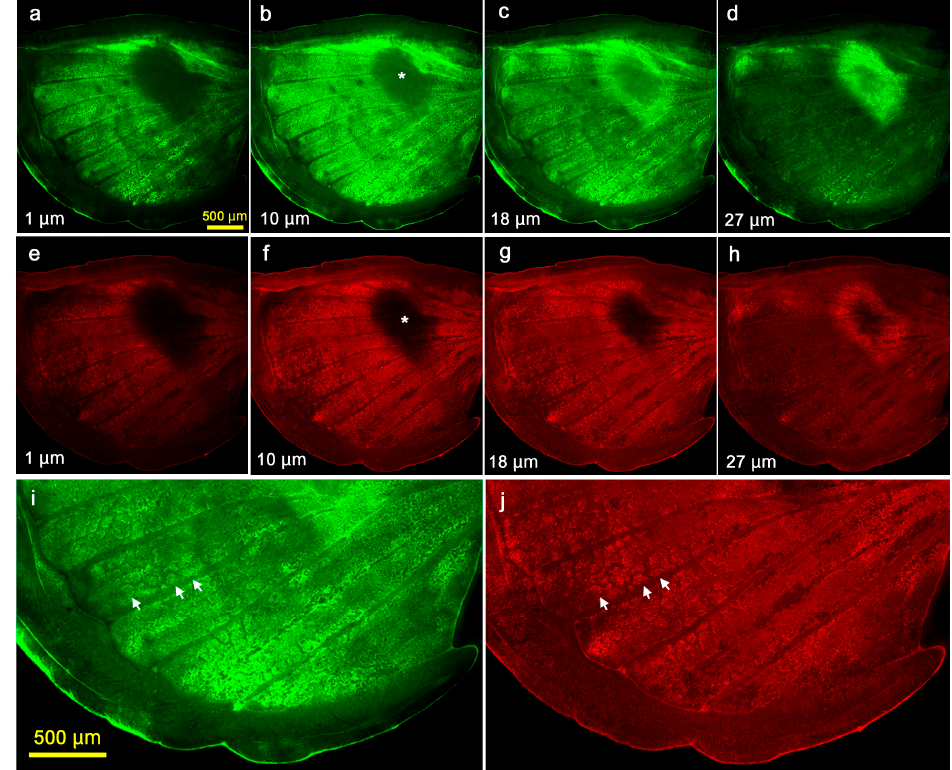
Figure 11. Serial optical sections of the dent at the prospective discal spot (the discal dent) and cellular clusters observed at the tissue level. The uppermost section near the apical epithelial surface is set at 0 μ m. The depth from this section is indicated in each panel. Asterisks indicate the center of the discal dent. ( a–d ) CFSE staining for the cytoplasm. ( e–h ) MitoRed staining for mitochondria. ( i ) High magnification of c. Three representative clusters are indicated by arrows. ( j ) High magnification of g. Three representative clusters are indicated by arrows.